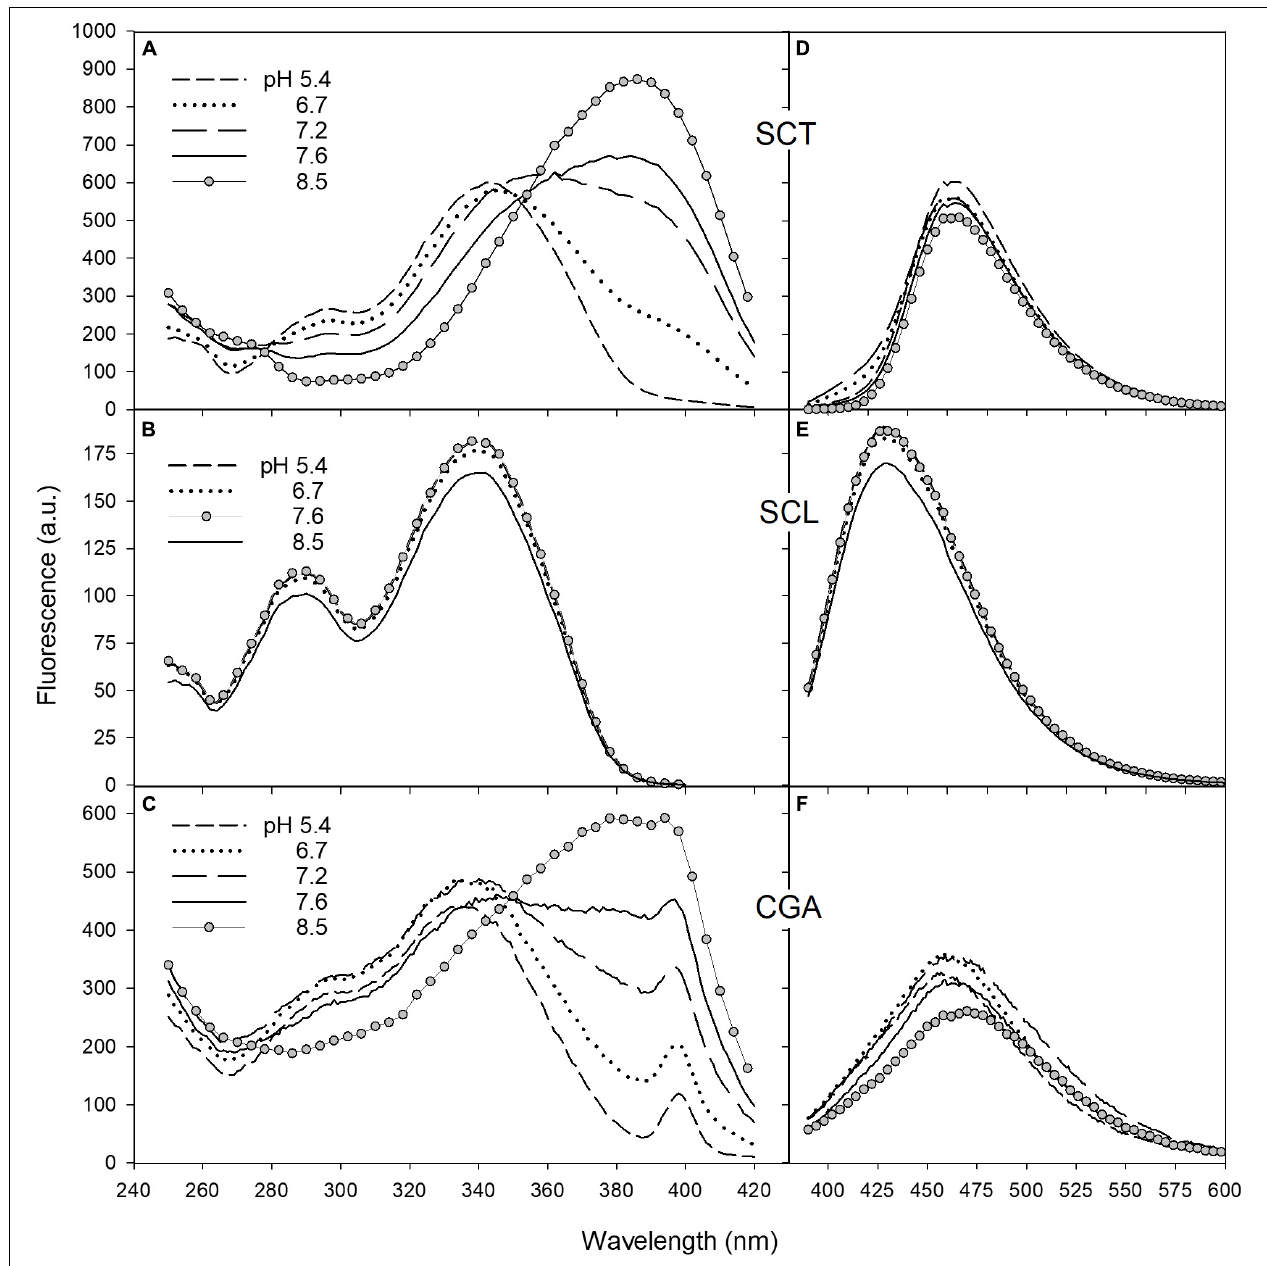
FIGURE 5 | The fluorescence excitation and emission spectra of SCT (A,D) , SCL (B,E) , and CGA (C,F) in phosphate buffer at different pH. Excitation spectra were recorded with emission wavebands set at 460 nm for SCT and CGA and at 420 nm for SCL. The peak observed in C at 398 nm corresponds to the excitation wavelength of the Raman scatter band of water at 460 nm. For emission spectra, excitation wavelengths were set at 330, 340, and 350 nm for CGA, SCL, and SCT, respectively. The acquisition parameters for SCT and SCL were ex/em slit width of 2.5/5 nm for excitation, 5/2.5 nm for emission, PMT voltage = 600 V; for CGA, they were ex/em slit width of 5/10 nm for excitation, 10/5 nm for emission, PMT voltage = 900